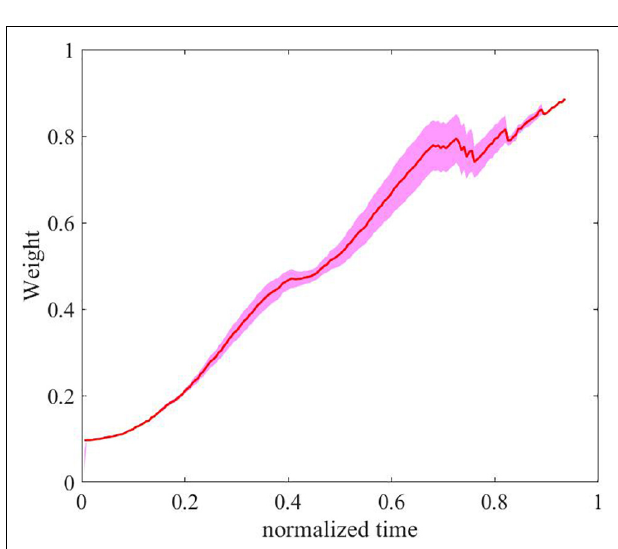
FIGURE 13 | The arbitration factor for the robot autonomy from the speed shared controller in a normalized time scale.